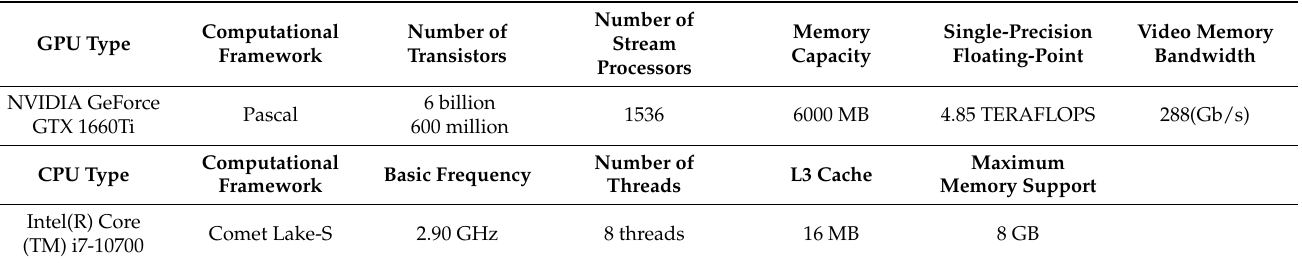
Table 1. Key parameters of GPU and CPU.